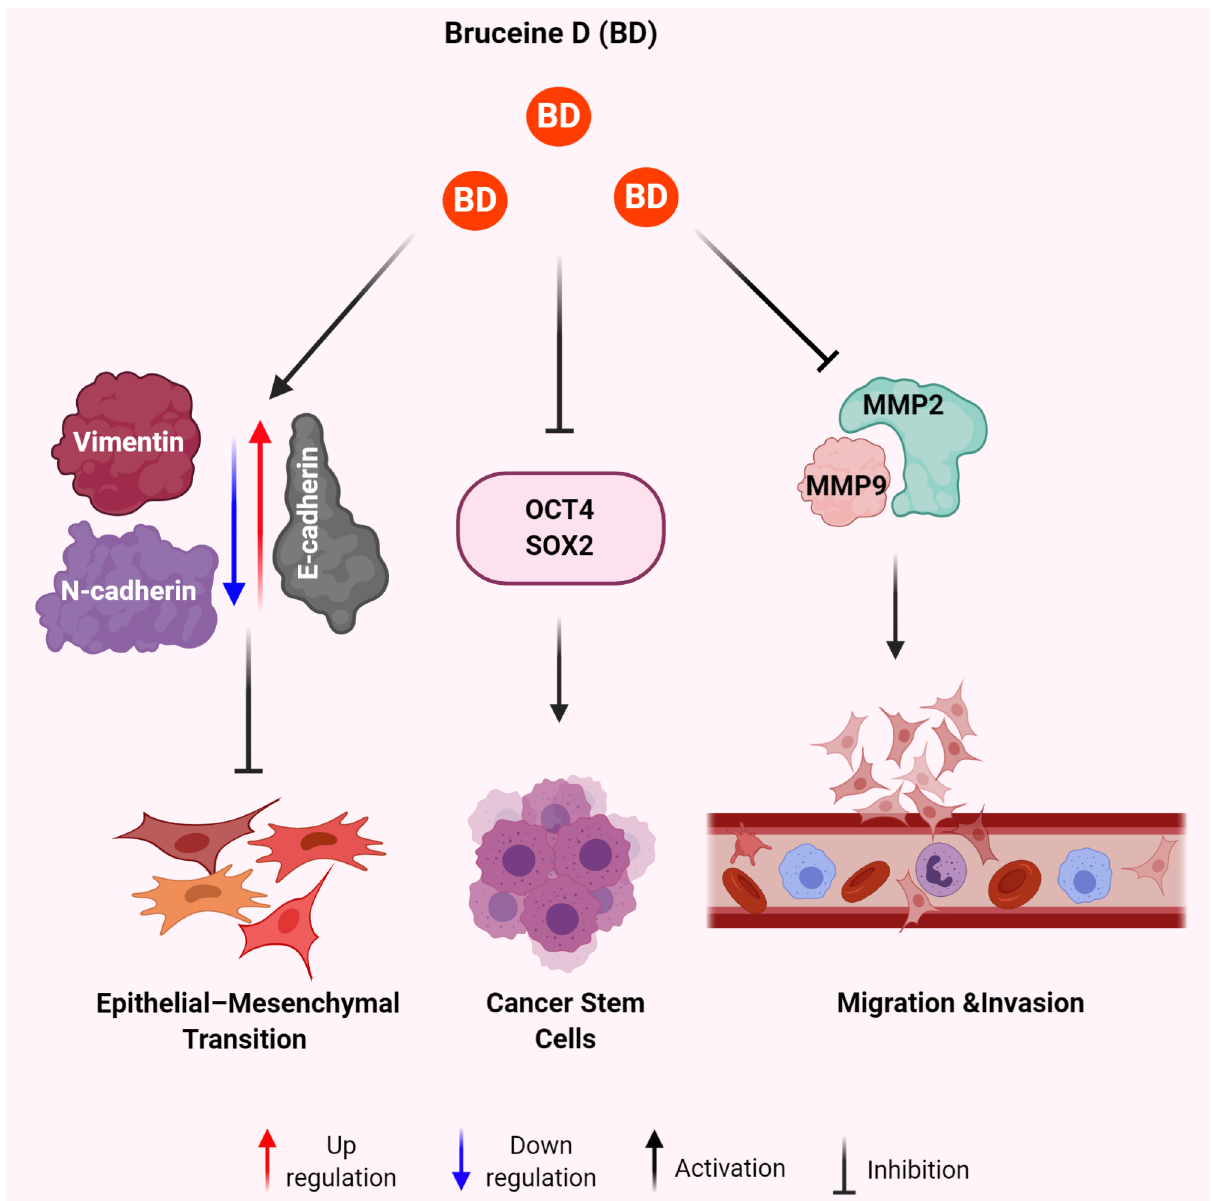
Figure 2. Mechanisms of BD for anti-metastatic effect in human malignancies. BD results in increased expression of E-cadherin and decreased expression of vimentin and N-cadherin leading to decreased EMT. BD treatment leads to decreased expression of OCT4 and SOX2 to eradicate the CSCs. BD exposure attenuates the expression of MMP2 and MMP9 to inhibit migration and invasion of cancer